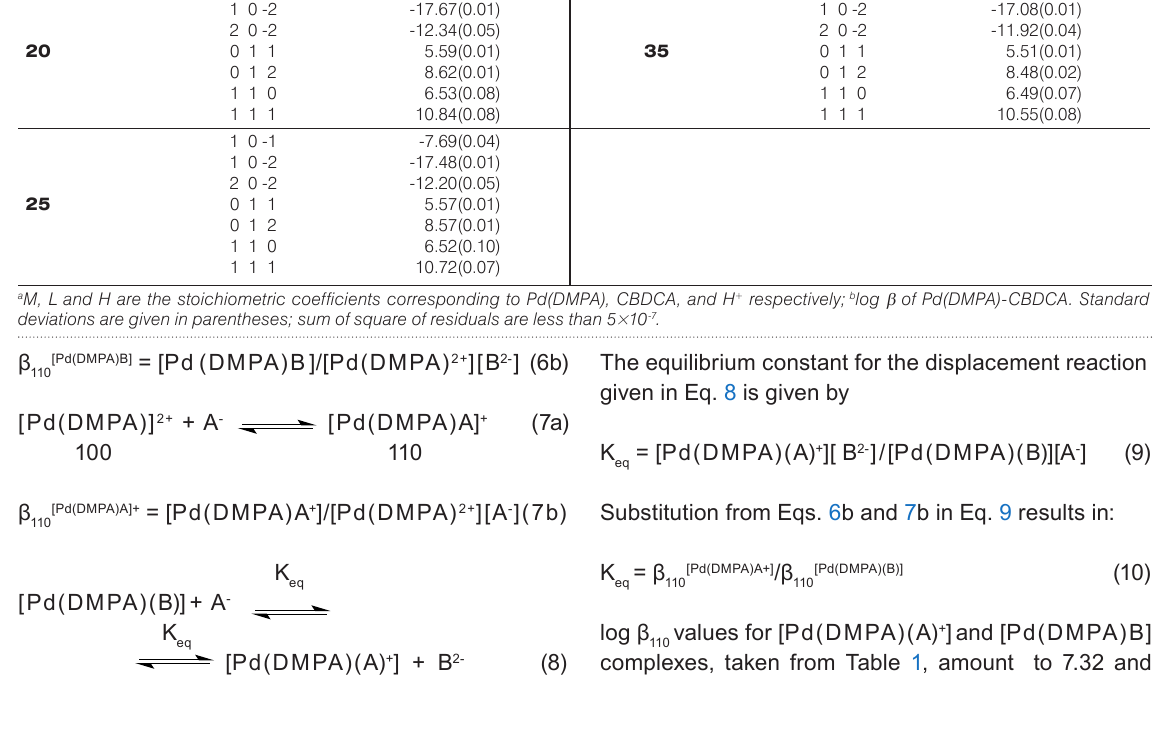
complexes, taken from Table 1, amount to 7.32 and